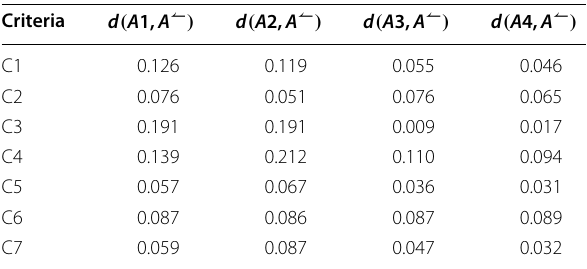
Table 13 Distances between A i ( i = 1,2,3, 4 ) and A ↼ each criterion